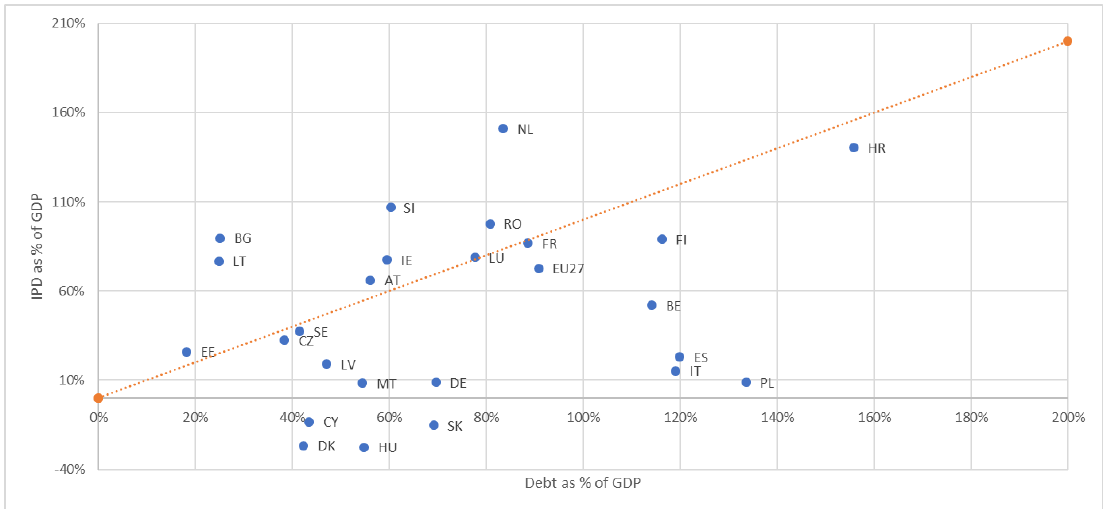
Figure 4. IPD plotted against explicit debt, 2020. Source: Author’s calculations and (Eurostat 2021).